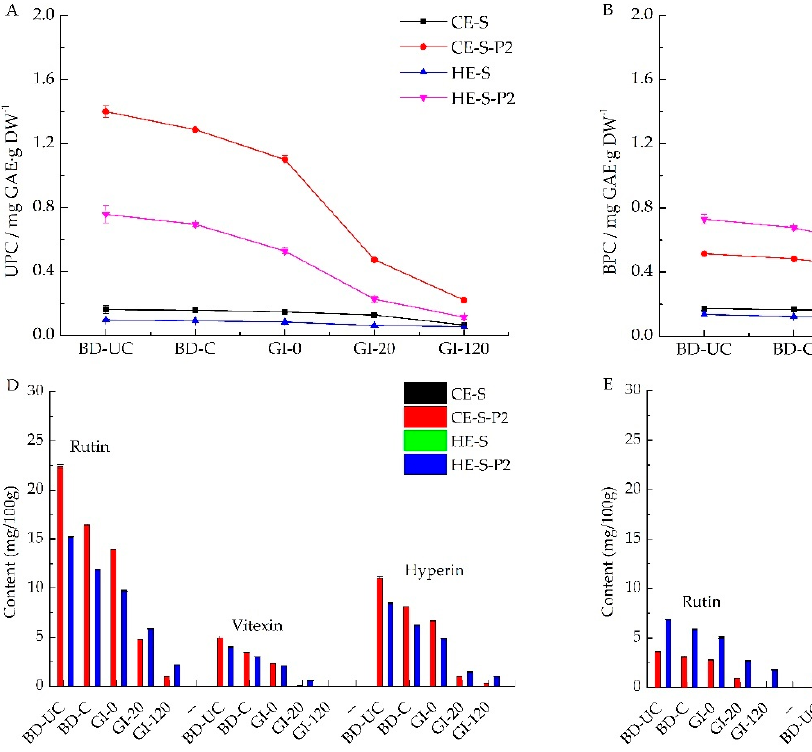
Figure 3. Contents of unbound ( A ), bound ( B ), and total ( C ) phenolics, and profiles in unbound ( D ), bound ( E ), and total ( F ) phenolic fractions of the cold and hot extruded noodles before digestion (uncooked and cooked) and residues during simulated in vitro gastrointestinal digestion for 0, 20, and 120 min. CE-S, cold extruded noodles with starch only; CE-S-P2, cold extruded noodles with starch and phenolics (2.0%); HE-S, hold extruded noodles with starch only; HE-S-P2, hold extruded noodles with starch and phenolics (2.0%); BD-UC, uncooked noodles before digestion; BD-C, cooked noodles before digestion; GI-0, gastrointestinal digestion for 0 min (after gastric digestion); GI-20, gastrointestinal digestion for 20 min; GI-120, gastrointestinal digestion for 120 min; UPC, BPC, and TPC, unbound, bound and total phenolic content respectively.